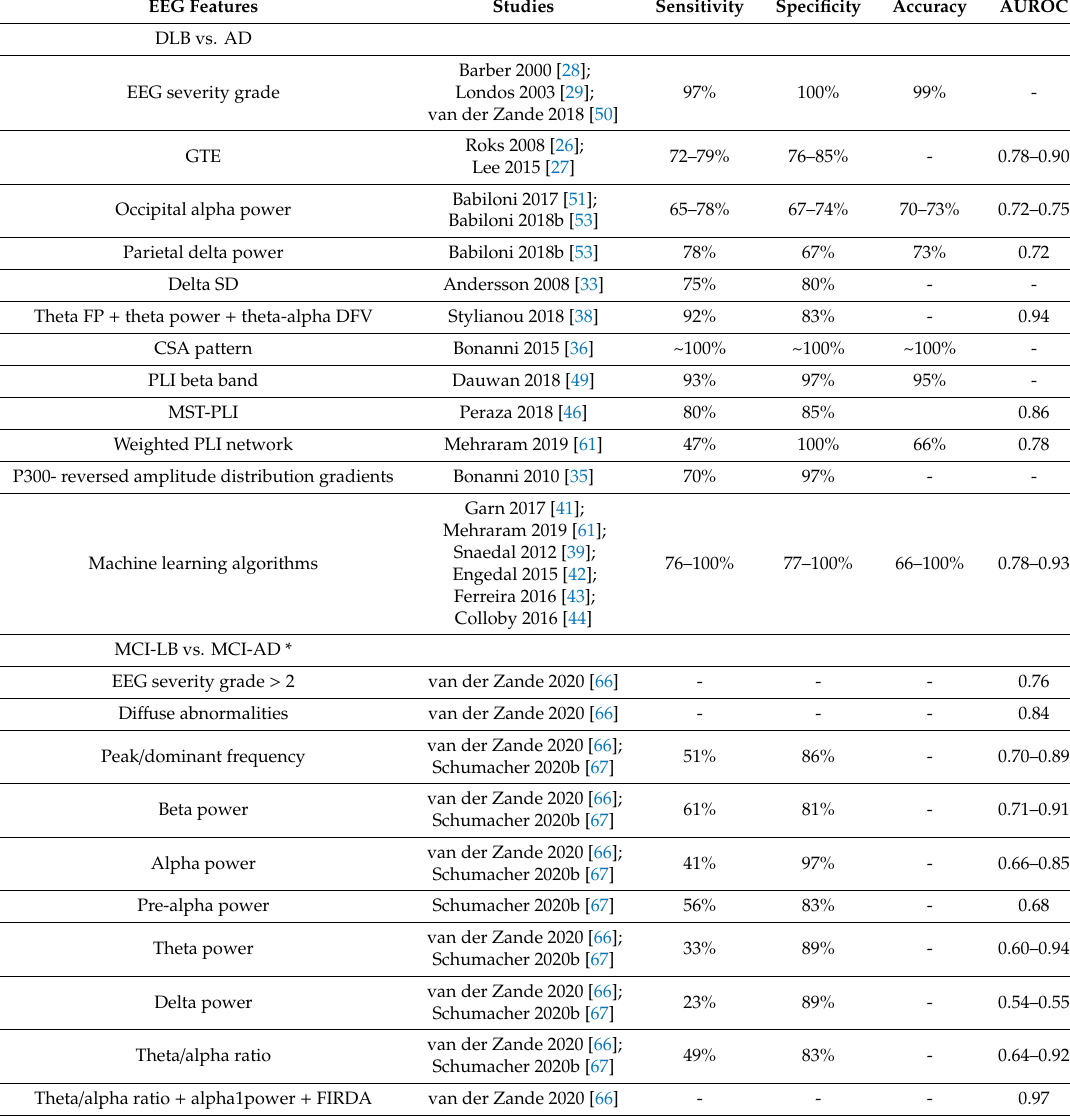
Table 4. Diagnostic accuracy of specific EEG